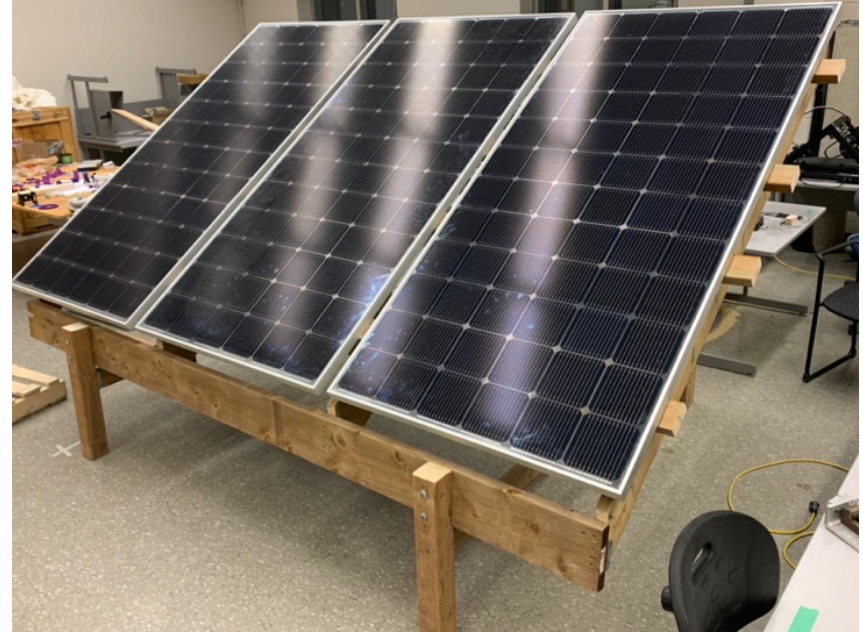
Figure 8. Finished system.